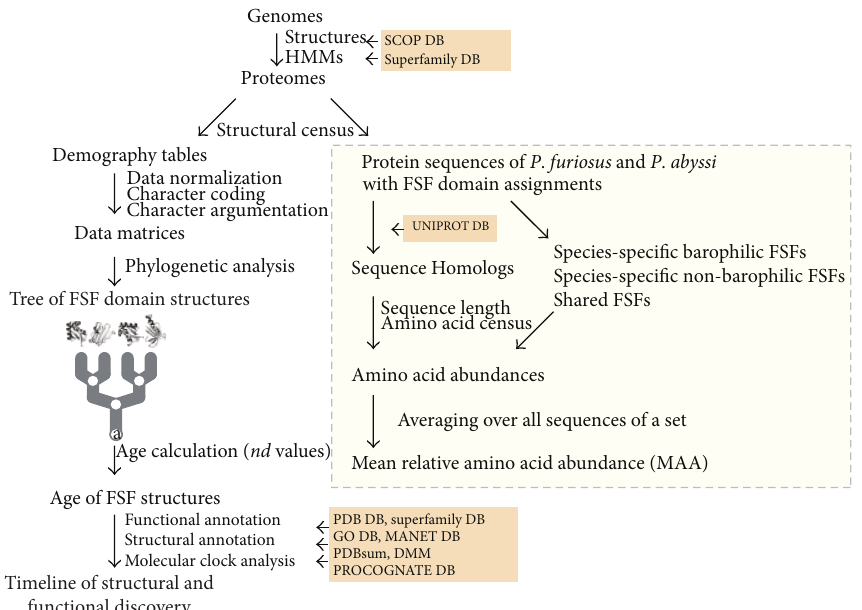
Figure 1: Flow chart describing the experimental strategy of the